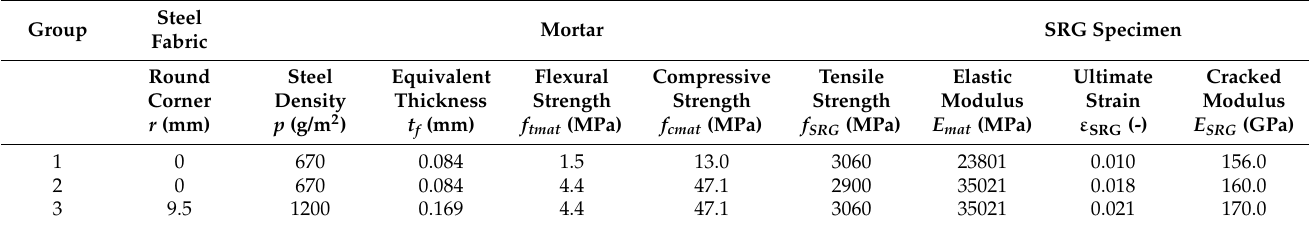
Table 4. Statistical values of the external reinforcement and its constituents for columns reported in [68].